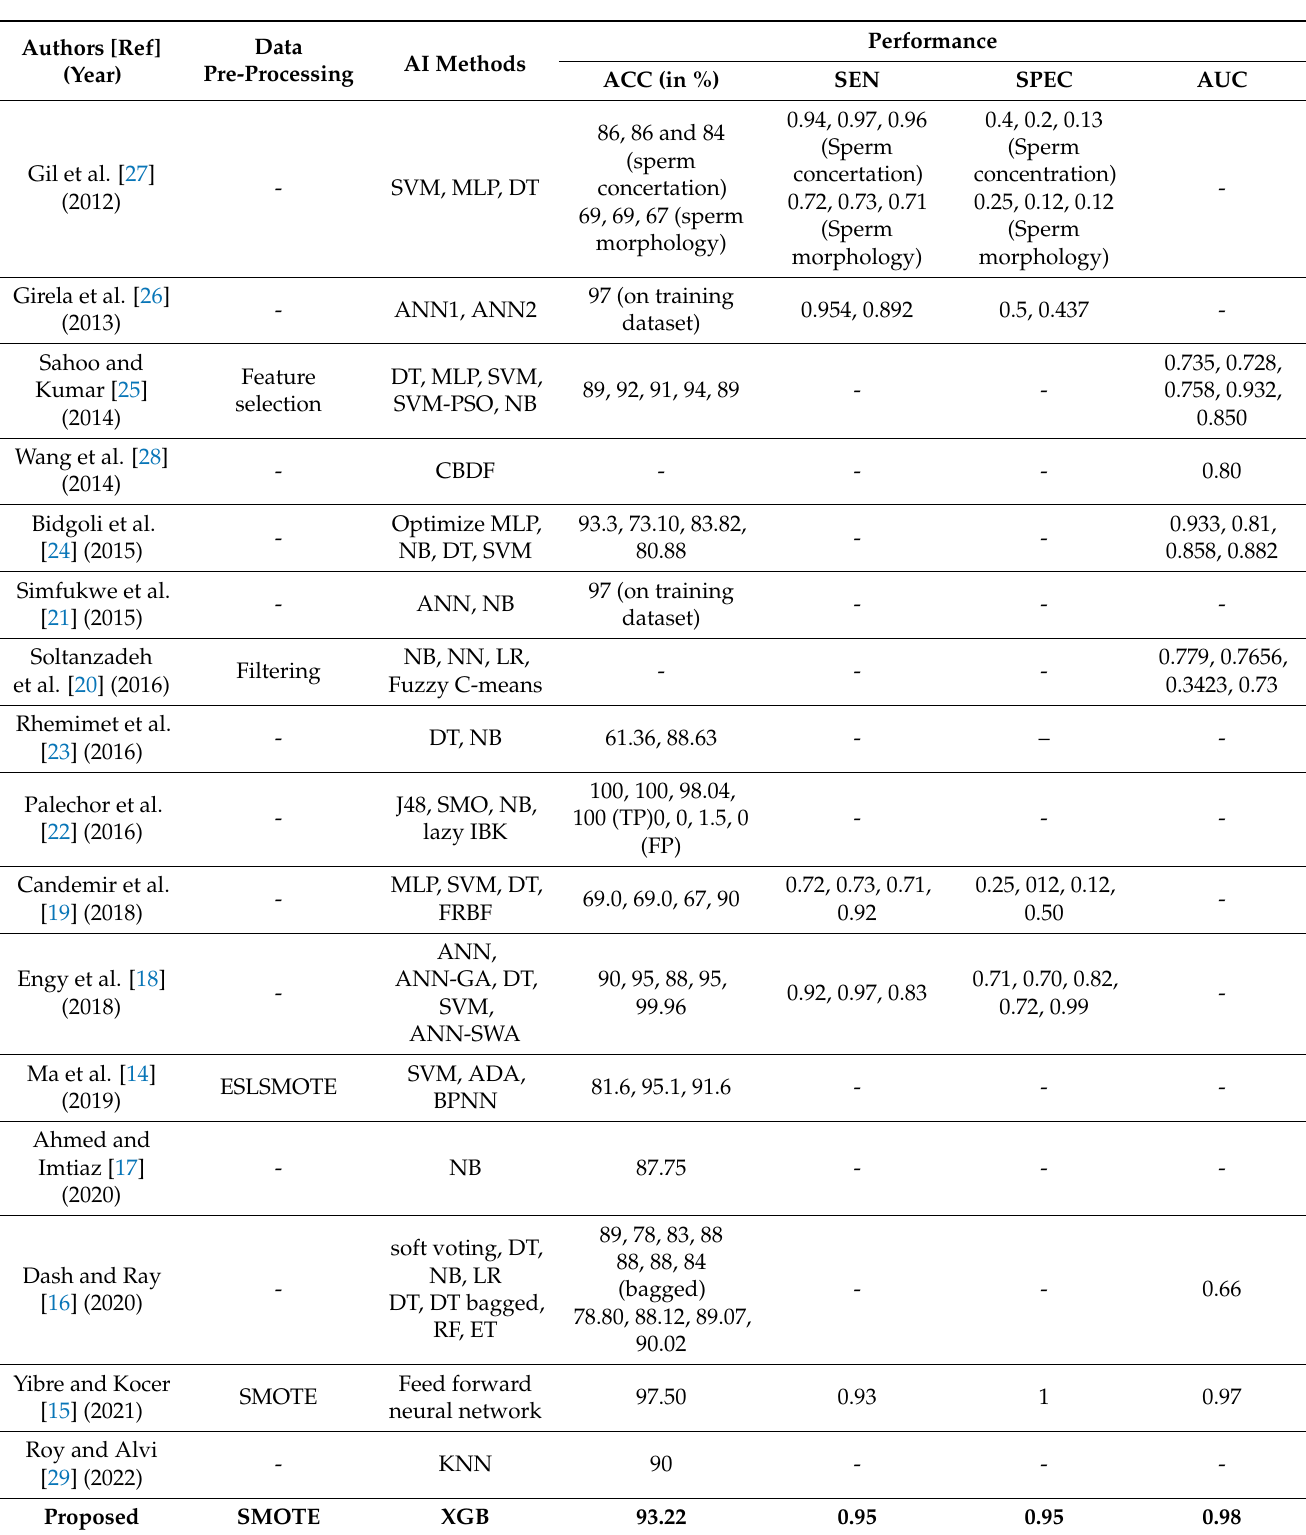
Table 7. Comparative study between proposed AI system to existing predictive systems on UCI dataset (according to